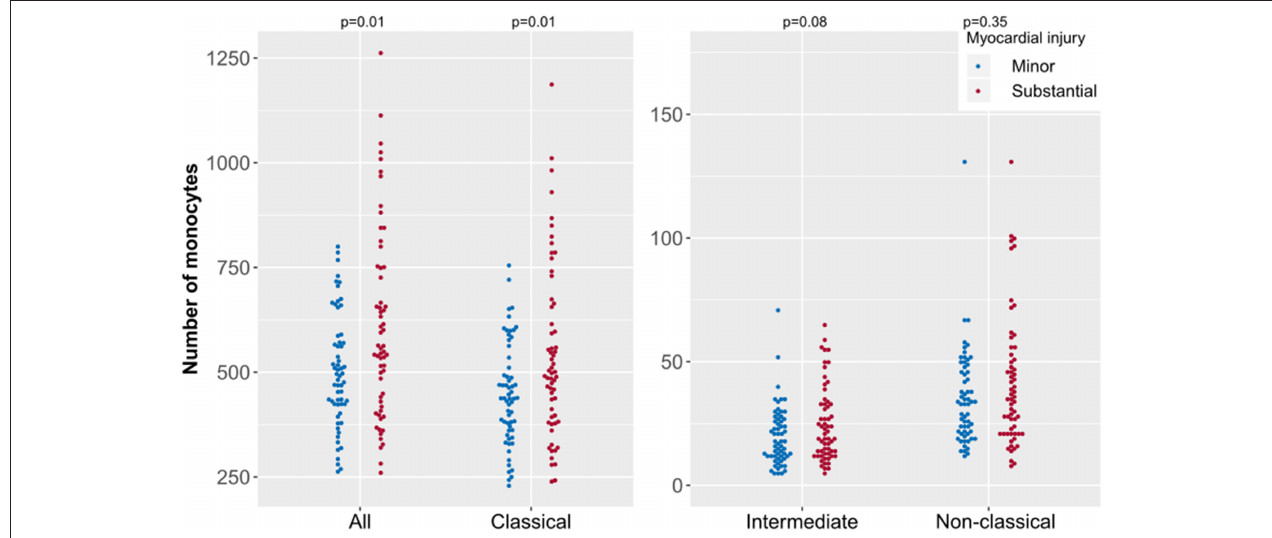
FIGURE 4 | Absolute monocyte counts of specific subsets according to extent of myocardial injury in chronic coronary syndrome (CCS). Presented are data from the CCS cohort ( n = 144) including patients with substantial ( n = 74) and with minor myocardial injury ( n = 70). CCS patients were stratified as having minor or substantial myocardial injury defined by super sensitivity cardiac troponin I values. Each point represents the monocyte count of one